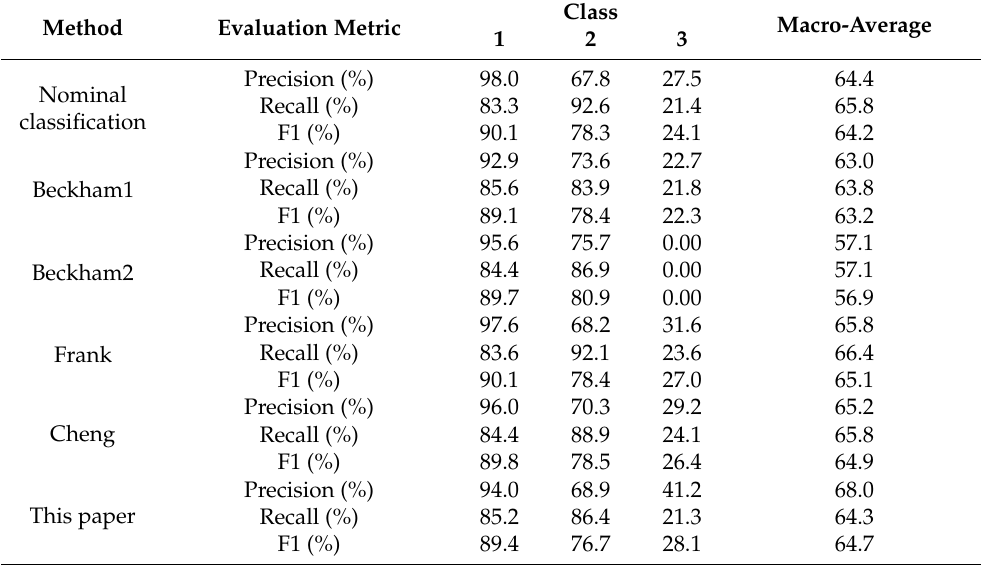
Table 6. Performance of six classification